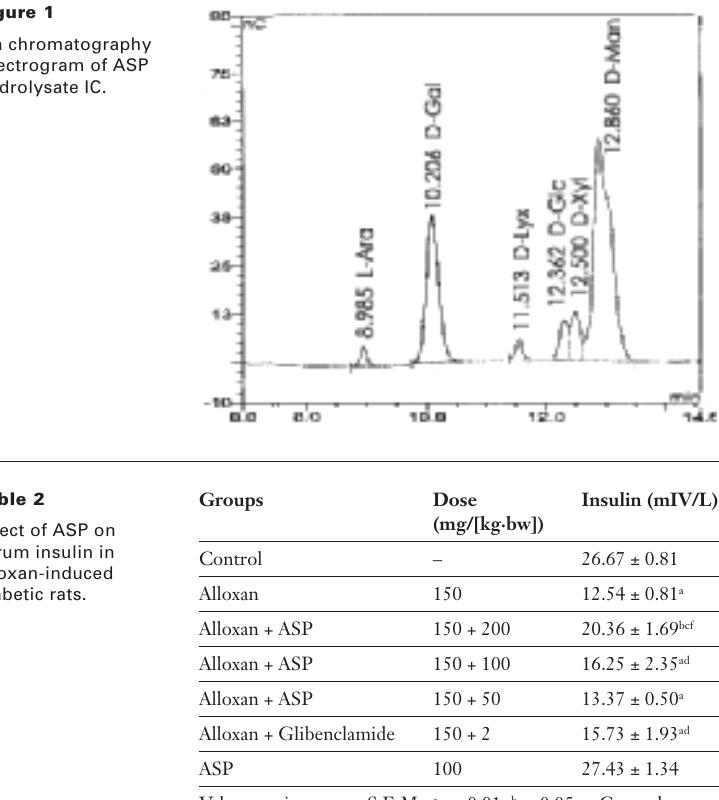
Effect of ASP on plasma glucose in alloxan-induced diabetic rats.